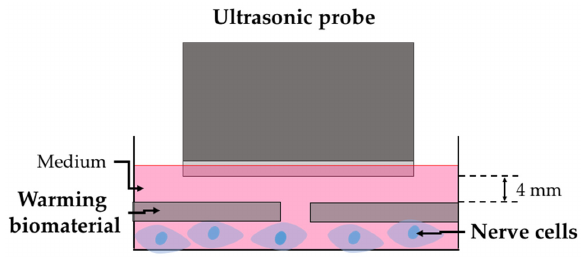
Figure 3. Schematic diagram of warming biomaterial combined with ultrasound on nerve cells.